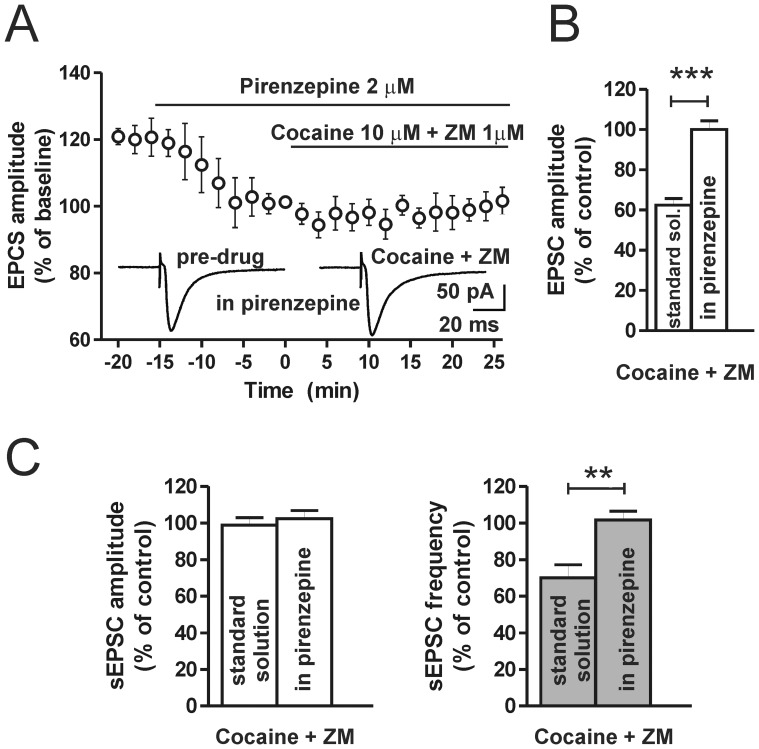
M1-like muscarinic receptor blockade prevents the reduction of excitatory synaptic transmission induced by cocaine and A2A-R antagonist.(A) Time-course showing evoked EPSC amplitude recorded from striatal MSNs in the continuous presence of the M1-like receptor blocker pirenzepine (2 µM). 10 µM cocaine plus 1 µM ZM are bath applied during pirenzepine perfusion. Representative traces of EPSC acquired 2 minutes before (left) and 20 minutes after (right) the co-application of cocaine plus ZM, bath applied 15 minutes after the onset of pirenzepine. (B) Histogram showing the effect on the EPSC amplitude of 25 minutes co-application of cocaine plus ZM in the presence of pirenzepine compared to the effect in the standard solution (EPSC amplitude t(10) = 6.9, P<0.001). (C) Histograms showing the effect of co-application of cocaine plus ZM on spontaneous EPSC amplitude (left) and frequency (right), in the presence of pirenzepine or in comparison to the effect in the standard solution (sEPSC frequency t(12) = 3.9, P<0.01). **P<0.01; ***P<0.001.